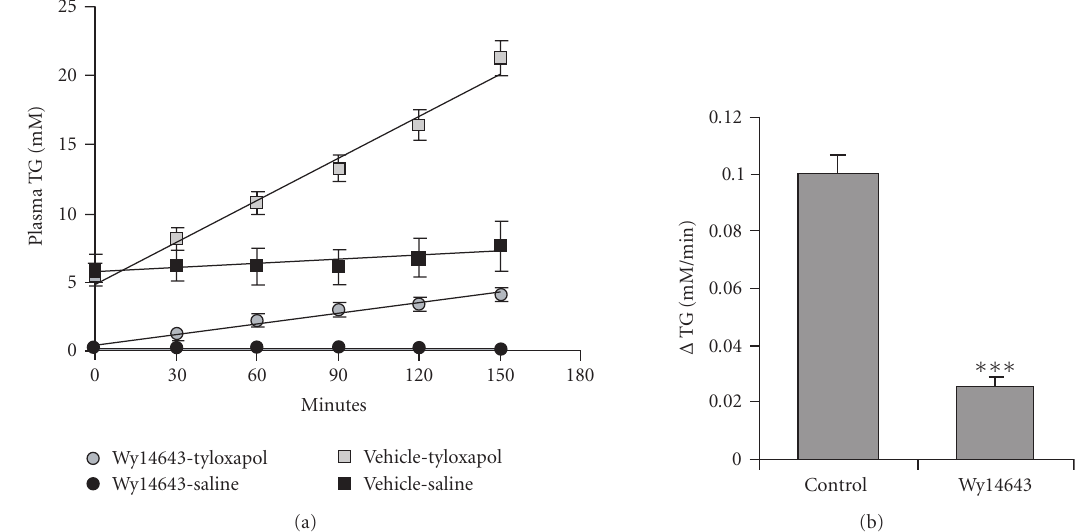
Figure 1: The PPAR α agonist Wy14643 dramatically lowers VLDL production in a mouse model of hypertriglyceridemia. Male Angptl4- transgenic mice ( n = 7 per group) were given vehicle or Wy14643 for 10 days (0.1% mixed in their food). After a 24-hour fast, the LPL- inhibitor tyloxapol (Triton WR1339, 500 mg/kg bodyweight as 15% solution in saline) or saline were injected intraorbitally. (a) Plasma triglyceride concentration was measured every 30 minutes to determine the VLDL production rate. (b) Mean rate of increase of plasma TG concentration in mice that received tyloxapol. Di ff erences were evaluated by Student’s t-test ( ∗∗∗ P < . 001). Error bars represent